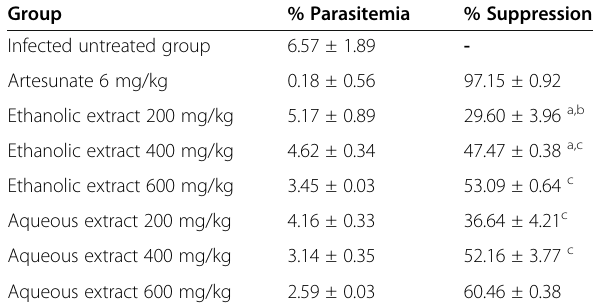
Table 6 Daily monitoring of food and water consumption in the untreated, aqueous and ethanolic extract groups